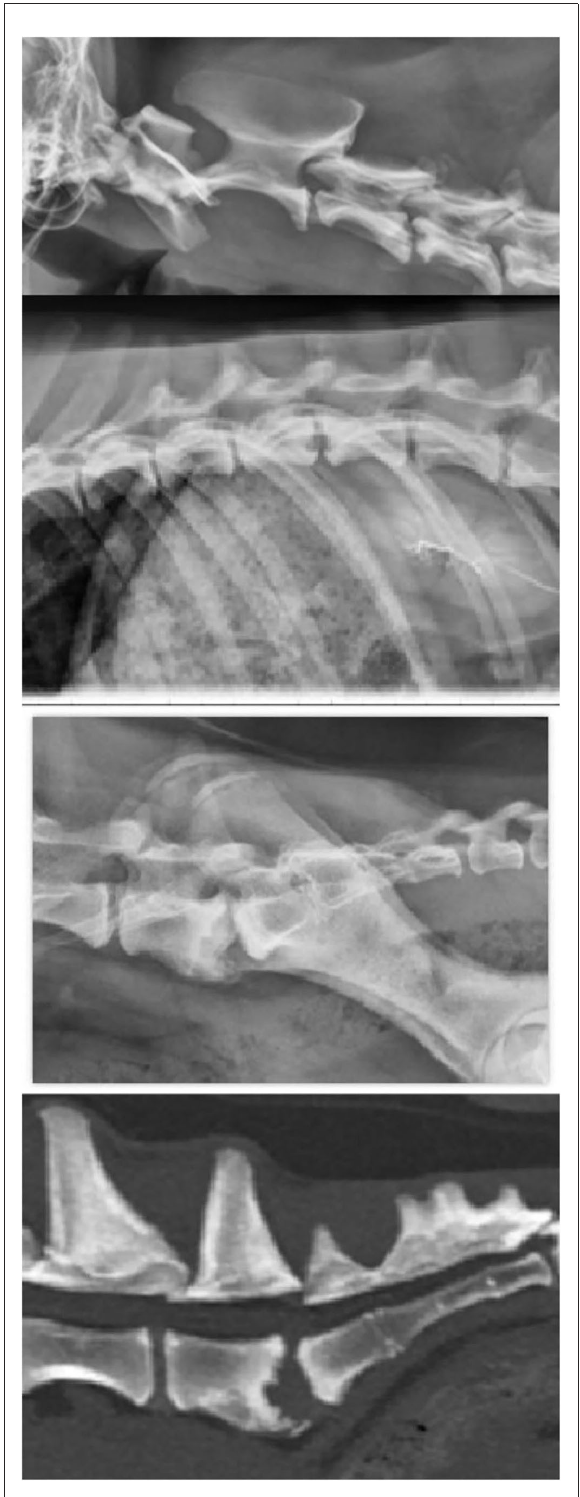
FIGURE2 Radiographs from of the cervical, thoracolumbar, and lumbosacral spine, and CT of the lumbosacral spine (top to bottom) from patient